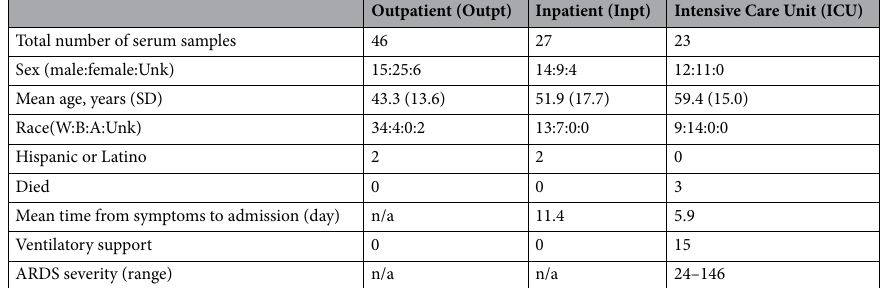
Outpatient (Outpt) Inpatient (Inpt) Intensive Care Unit